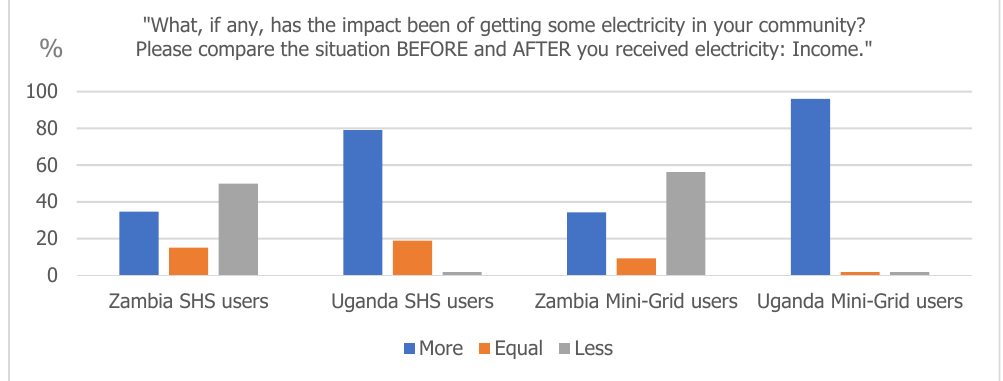
Figure 12. Impact of electrification on income among various subgroups; Responses in %.